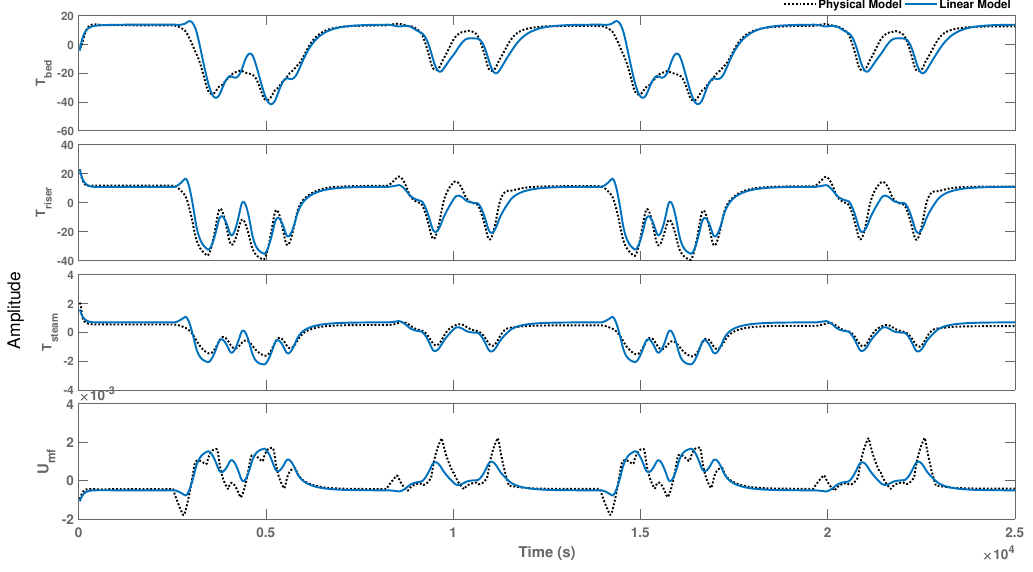
Figure 8. Simulated response comparison showing the linear model is within an expectable range to be used in controller